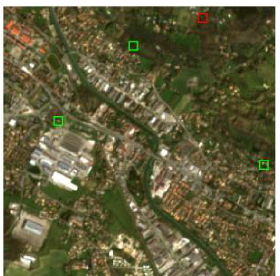
Figure 13 . Example of water towers detected in